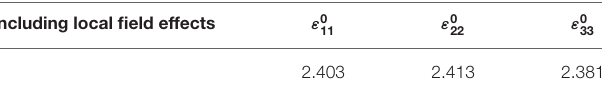
TABLE 2 | The electronic contribution to the static dielectric tensor ε 0 ij at constant vanishing strain ( η = 0) of α -DIPAB including local field effects (applying external electric field) and Van der Waals